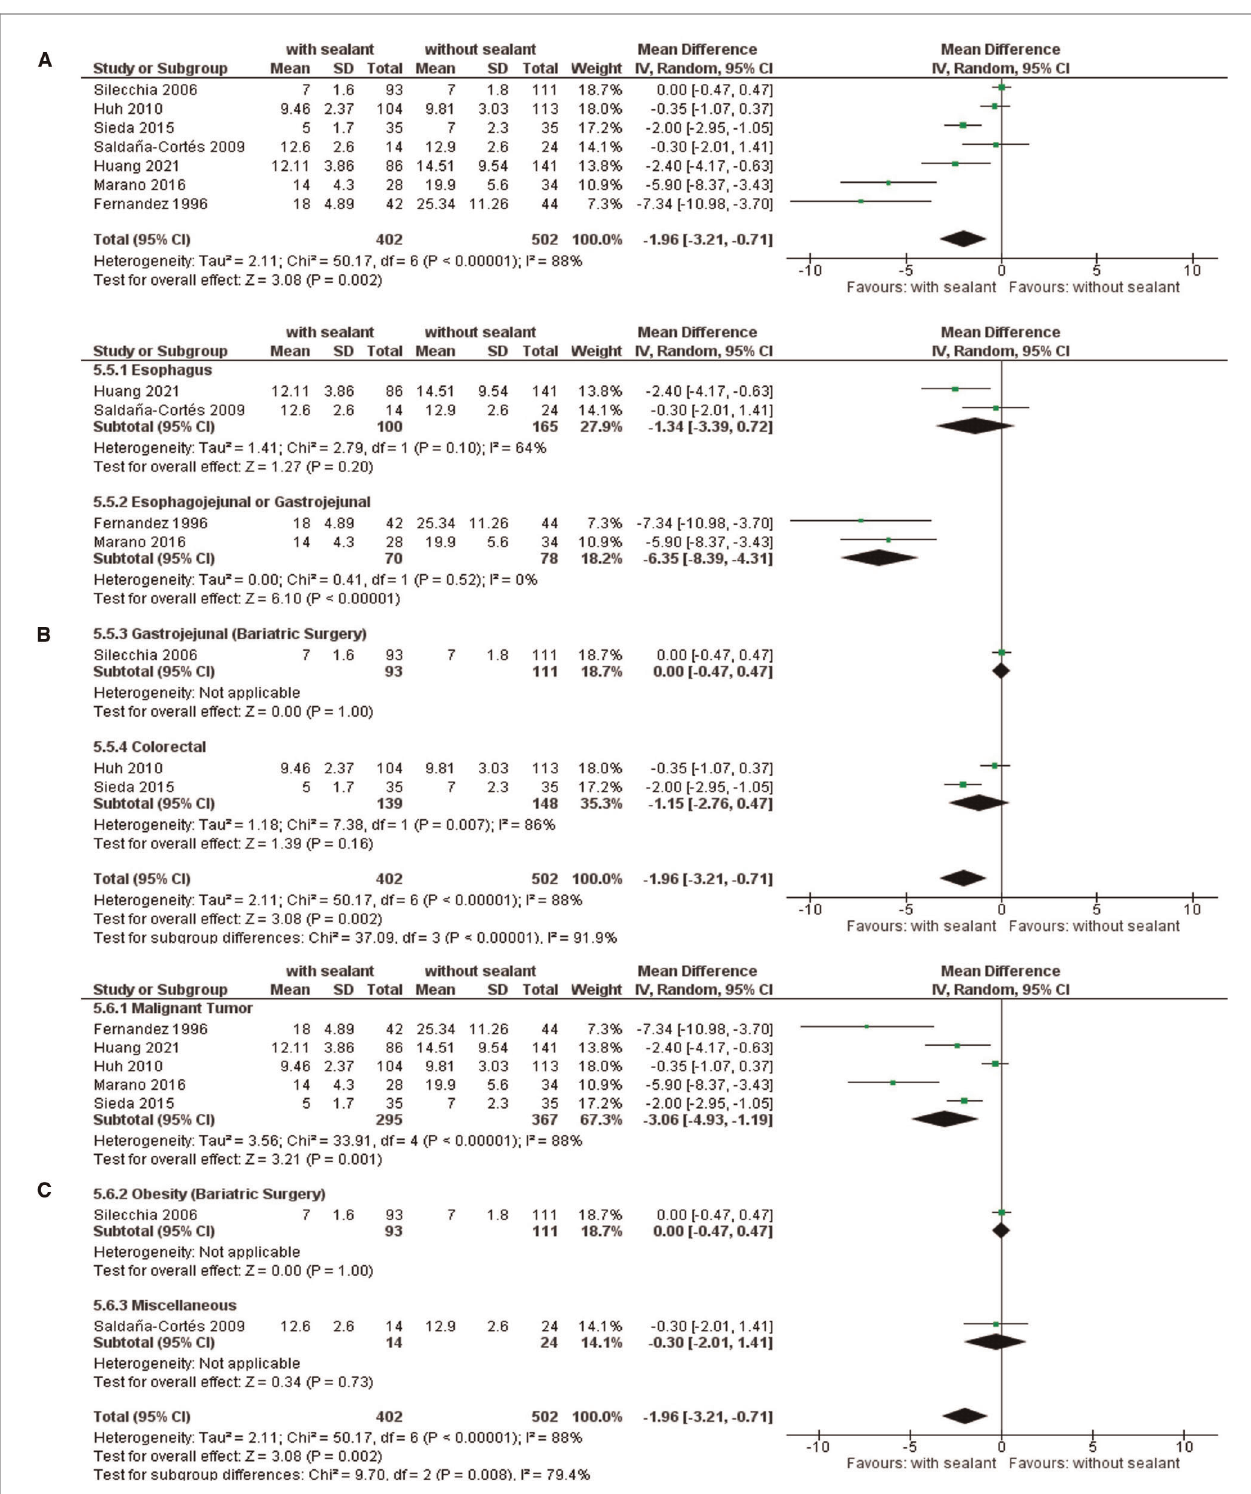
FIGURE 5 | Random-effects meta-analysis for the length of hospitalization in the intervention (coated or reinforced anastomoses) and control group. ( A ) Forest plot of all studies included. ( B ) Forest plot of subgroup analysis strati fi ed by location of anastomoses. ( C ) Forest plot of subgroup analysis strati fi ed by indication of surgery.